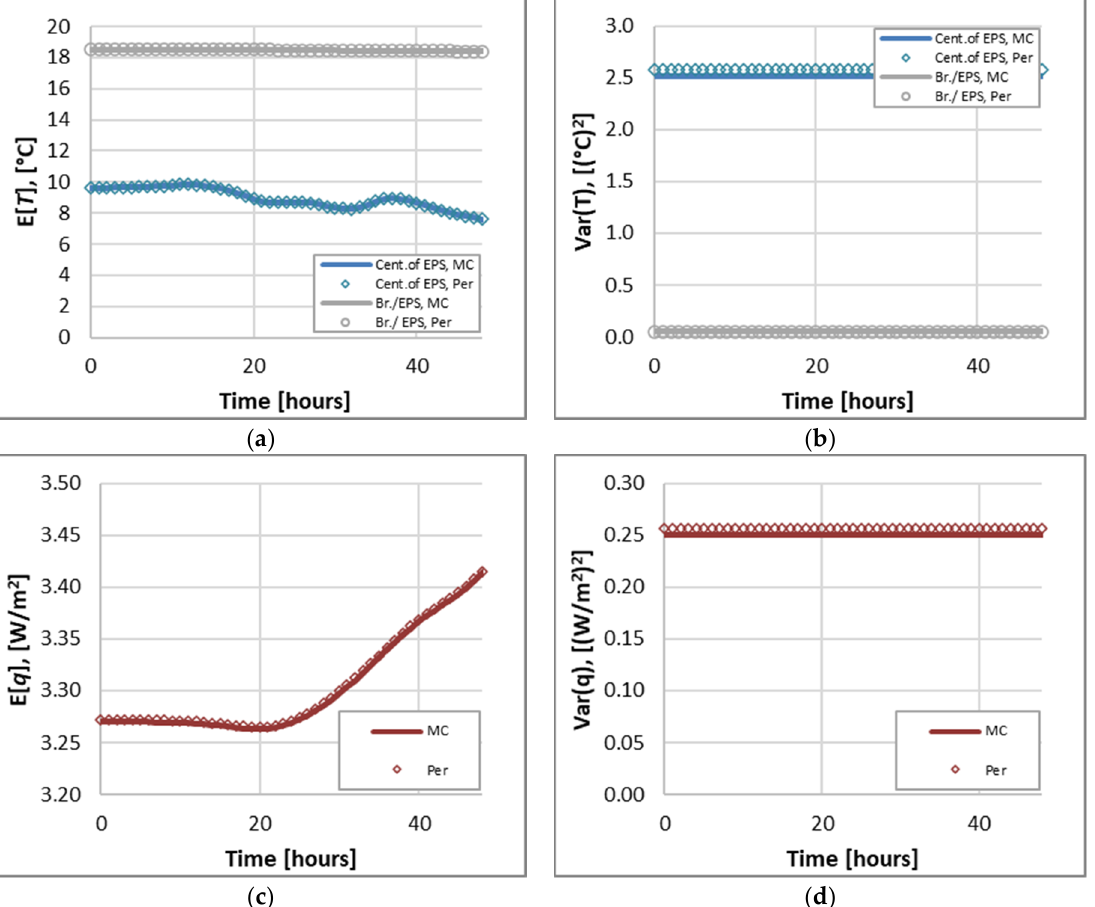
Figure 10. Comparison of ( a ) expected values and ( b ) variance of temperature in Point 3 (“Br./EPS”) and Point 4 (“Cent.of EPS”) and ( c ) expected values and ( d ) variance of heat flux during the first 48 h of the calculations using the Monte Carlo method (“MC”) and the perturbation method (“Per”) for Case 3.